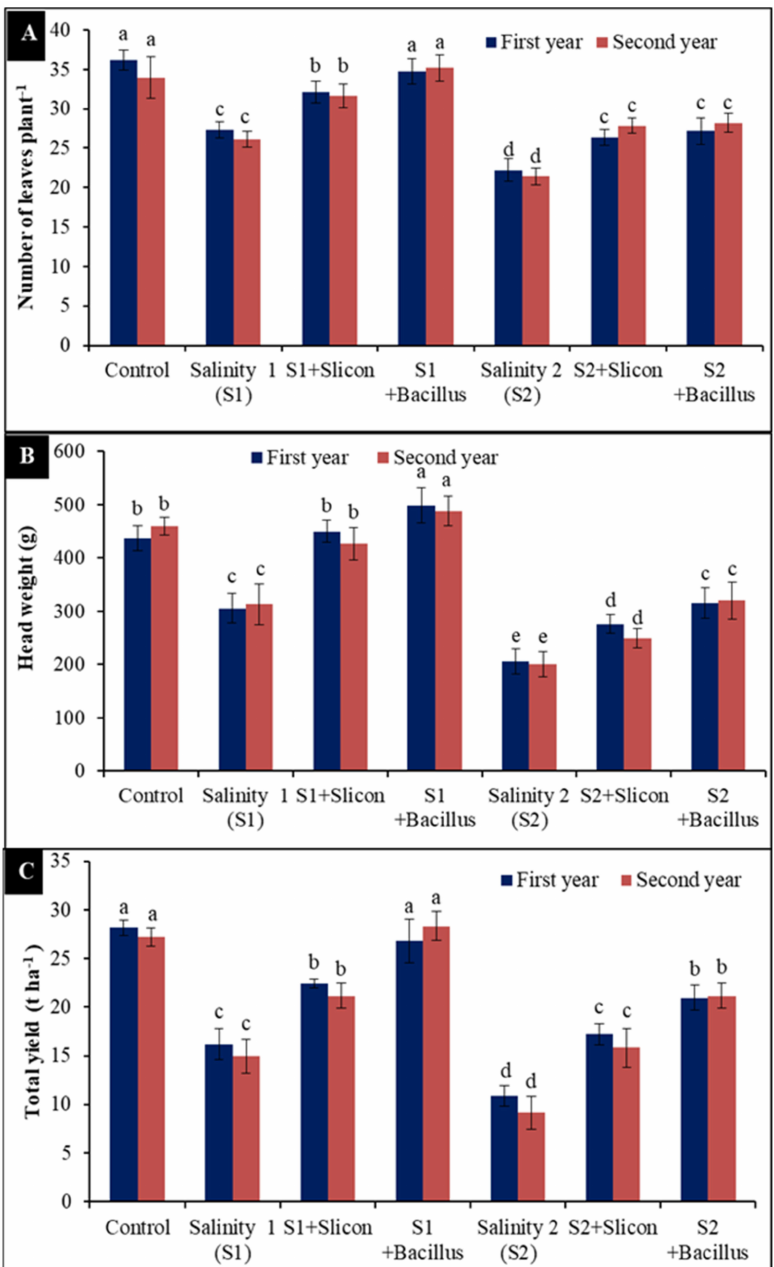
Figure 6. Effect of Si (potassium silicate at 2.7 mmol L − 1 ) and B. thuringiensis on leaves number ( A ) head weight ( B ) and total yield ( C ) in lettuce plants under salinity during two seasons (2019/2020 and 2020/2021). Different letters on the columns show significant differences between the treatments according to ANOVA, Duncan’s multiple range test at 0.05 level. Data is the mean ( ± SE) of tree replicates. Salinity 1 (S1): 4 dS m − 1 , Salinity 2 (S2): 8 dS m − 1